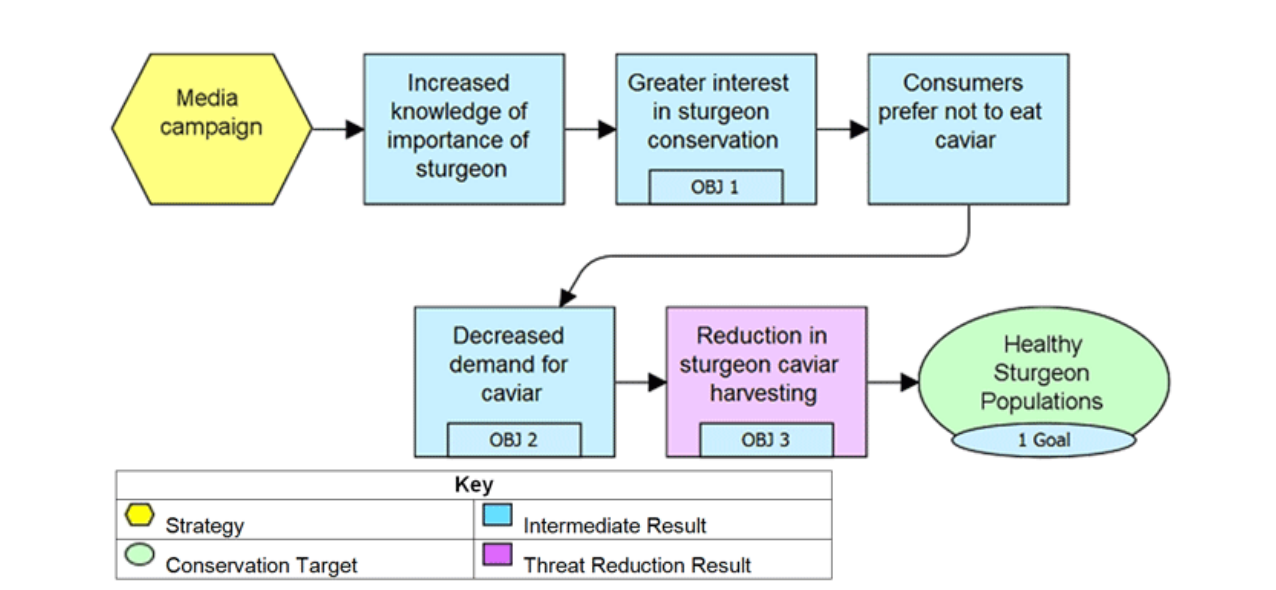
Fig. 5 . Fully developed results